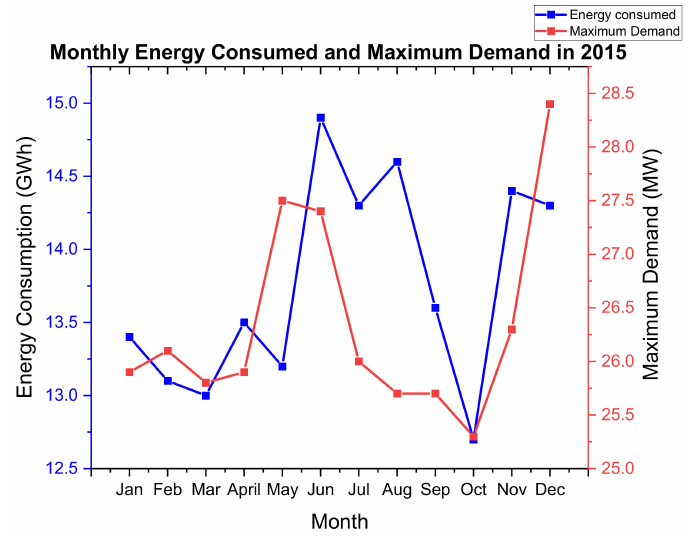
Figure 5. The 2015 monthly energy consumption and maximum demand for the Mimosa mine.